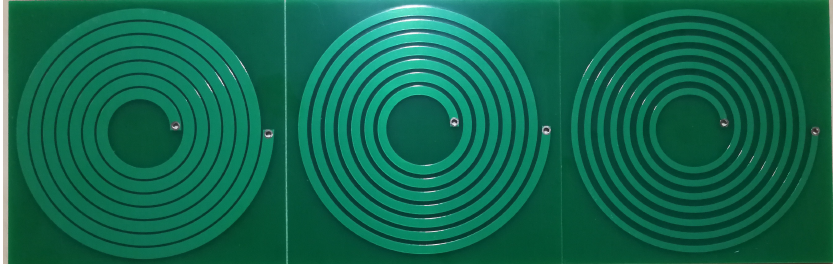
Figure 17. Group-2 prototypes with track width 5 mm ( left ), 4.2 mm ( middle ) and 3 mm ( right ).